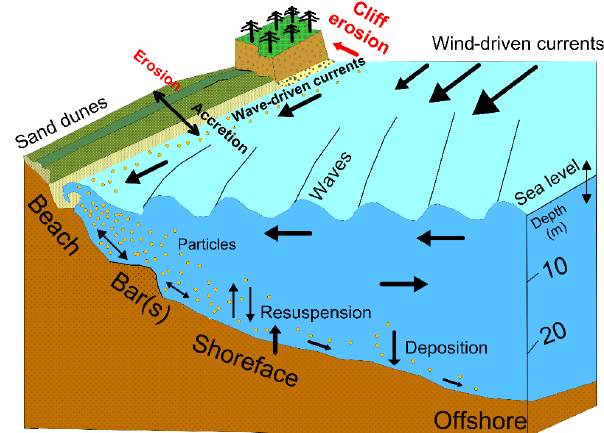
Figure 4. Main coastal topographic features and the erosion and accretion processes at the Baltic Sea shores (redrawn and modified from Harff et al.,